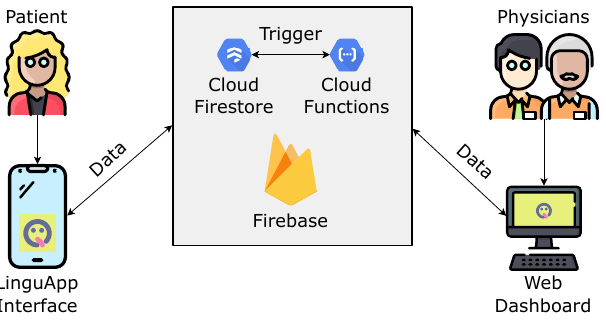
Figure 1. Simple sketch of the proposed